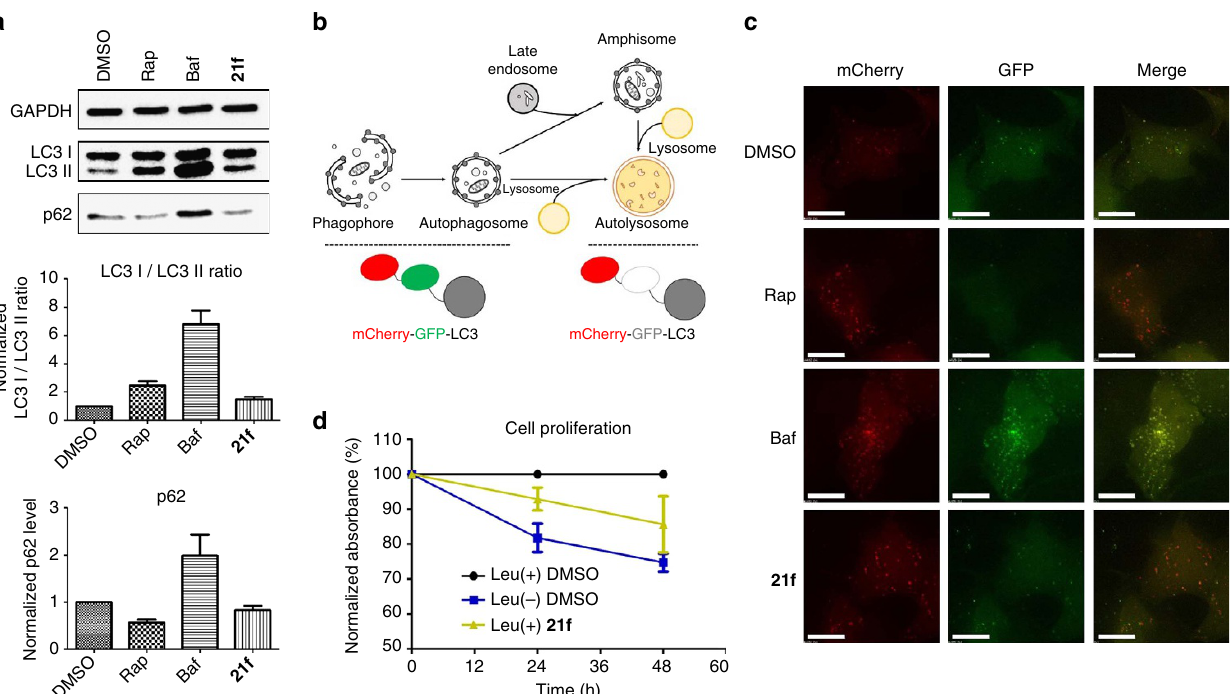
Figure 6 | Autophagic activation of 21f and its reduction on cell proliferation. ( a ) Western blot analysis of LC3 and p62. HeLa cells were treated with 200nM of rapamycin (Rap), 10nM of bafilomycin A1 (Baf) or 20 m M of 21f for 6h. Quantification of relative band intensity of LC3 I/LC3 II ratio and p62 expression level were normalized with DMSO sample. Data from at least three independent experiments were normalized; error bars represent the s.d. ( b ) Schematic depiction of mCherry-GFP-LC3 system. The pH decreases with lysosome fusion to autophagosome, thereby quenching GFP fluorescence while mCherry fluorescence is maintained. ( c ) mCherry and GFP fluorescence images. HeLa cells were transfected with mCherry-GFP-LC3 plasmid and treated with 200nM of Rap, 10nM of Baf or 20 m M of 21f for 6h. Scale bar, 15 m m. ( d ) Normalized cellular proliferation level in HEK293T cells was measured by colorimetric BrdU assay under the Leu-deprived media or under the normal media in the absence and presence of 21f (5 m M). Error bars represent the